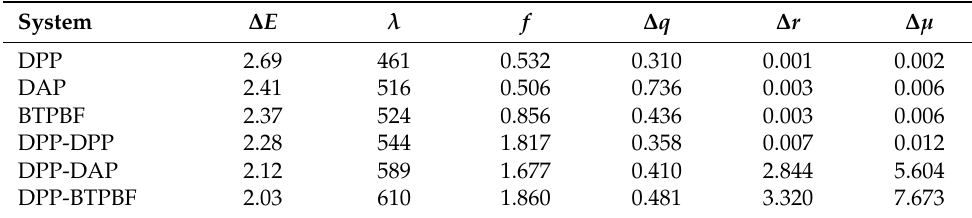
Table 1. Characterization of the S 0 → S 1 electron transition in DPP, DAP, and BTPBF monomers, as well as in DPP-DPP, DPP-DAP, and DPP-BTPBF A-A’ units: transition energies ( ∆ E , eV), wavelengths ( λ , nm), oscillator strengths ( f , dimensionless), amount of charge transferred (|e|), charge transfer distances (Å), and change in dipole moments (D).